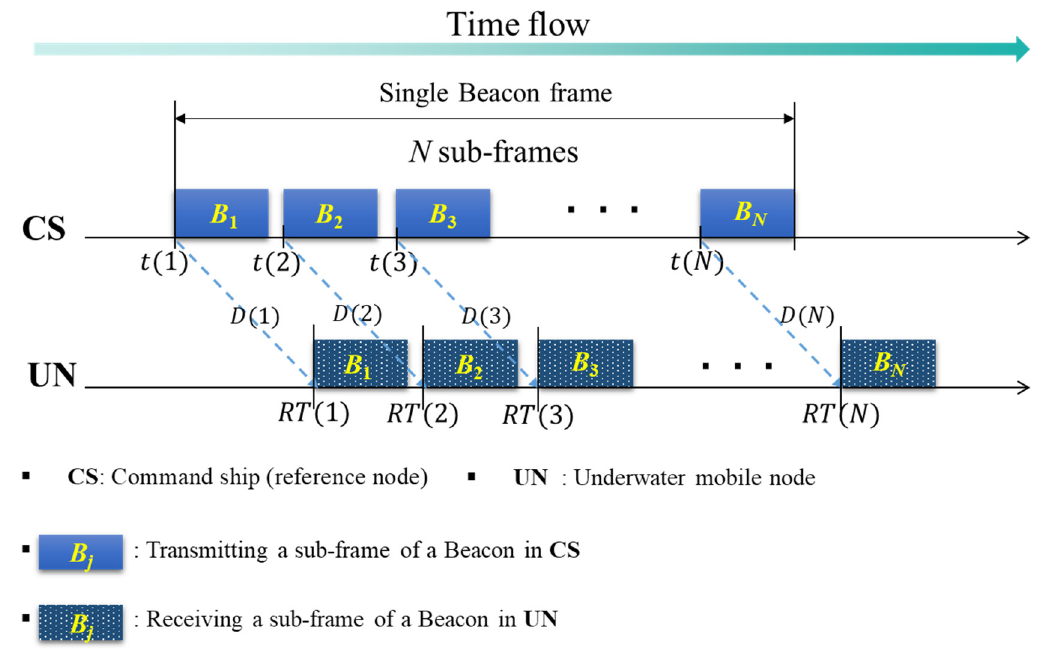
Figure 2. Illustration of parameters for PTA-Sync.